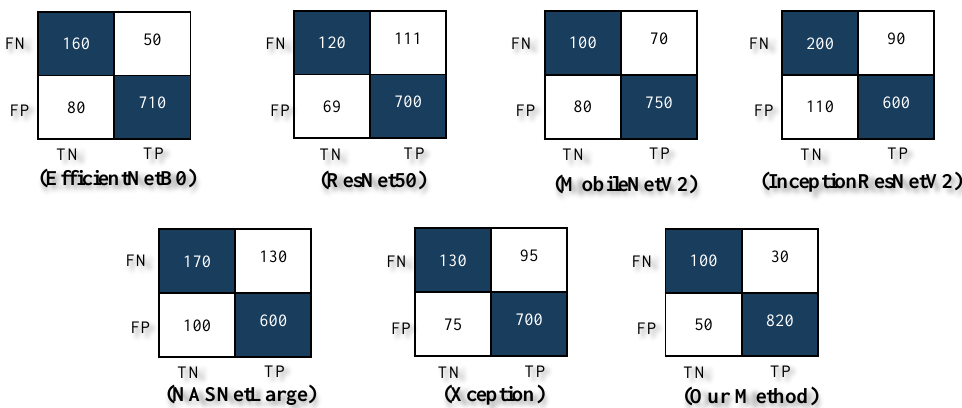
Figure 7. Confusion matrix for EfficientNetB0, ResNet50, MobileNetV2, InceptionResNetv2, NasNet- Large, Xception and our intergated